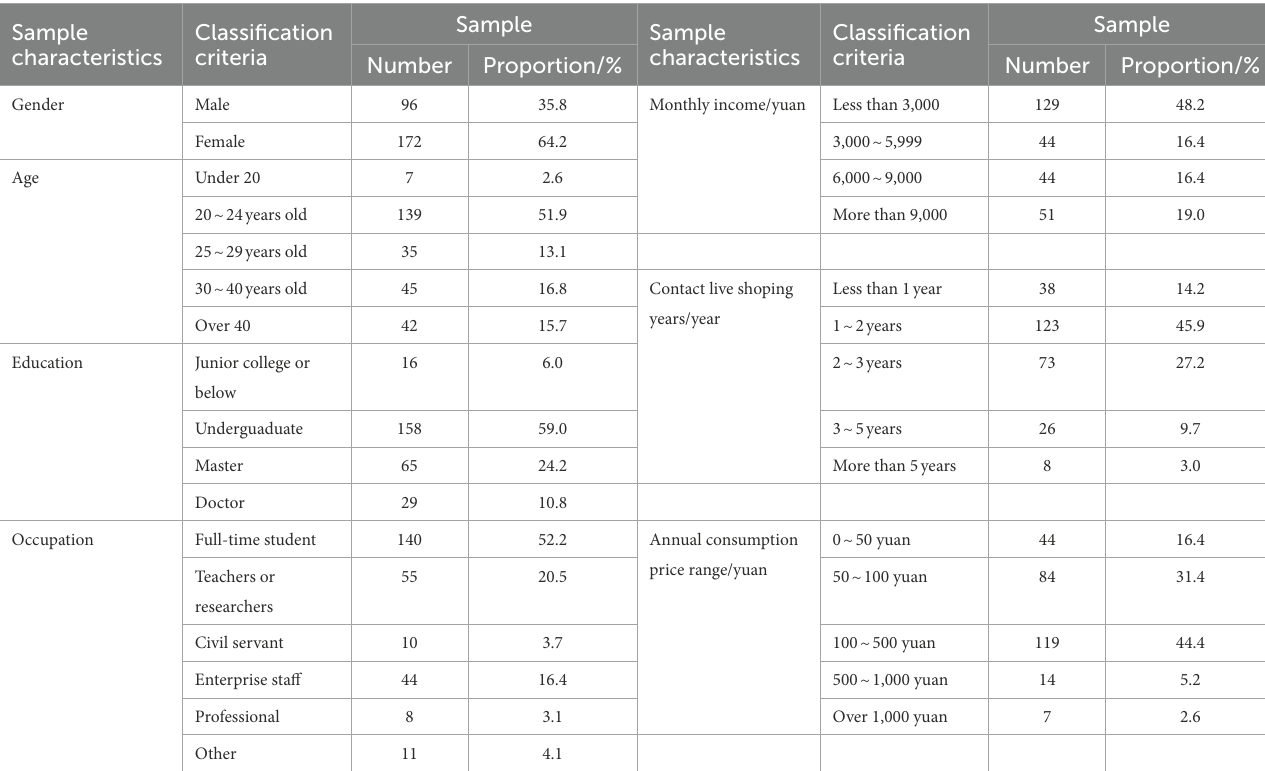
TABLE 1 Demographic statistics of survey samples ( n =